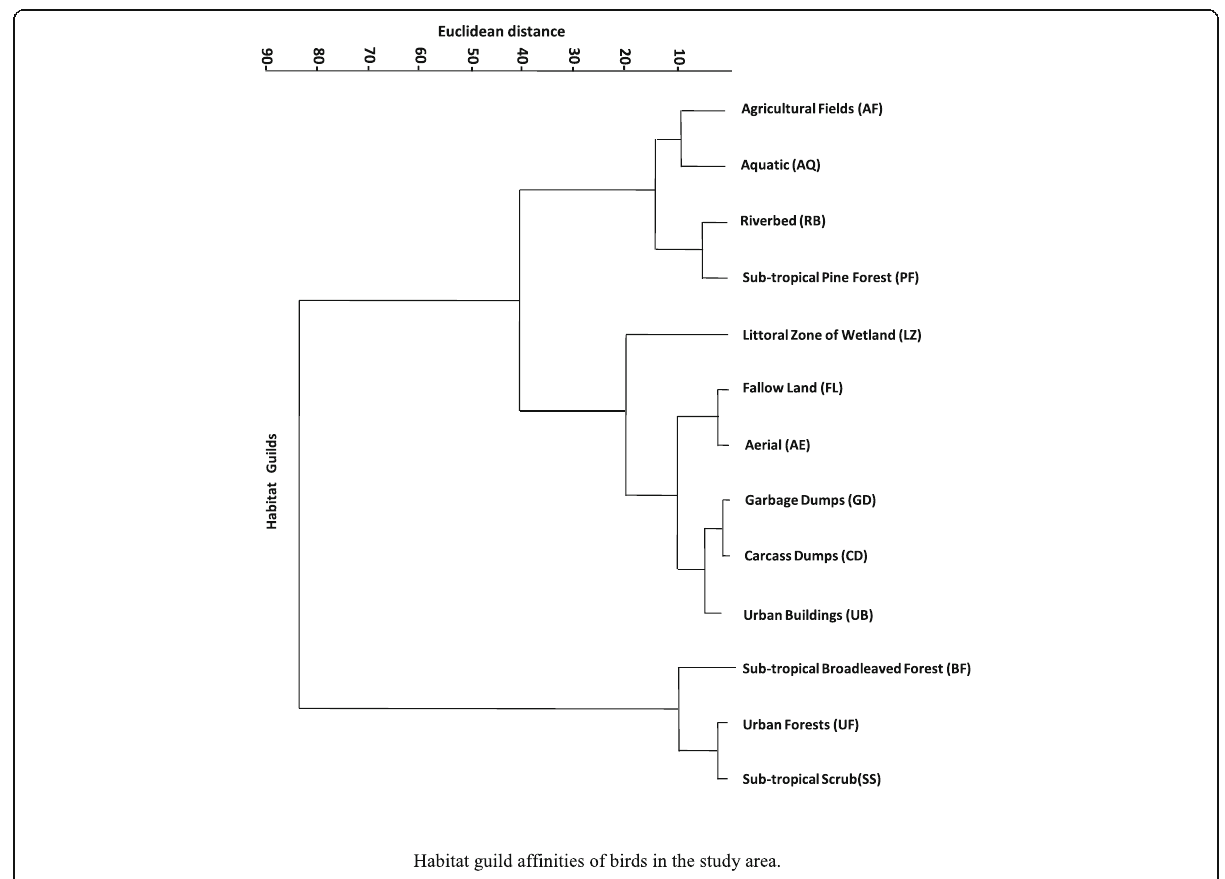
Fig. 5 Habitat guild affinities of birds in the study